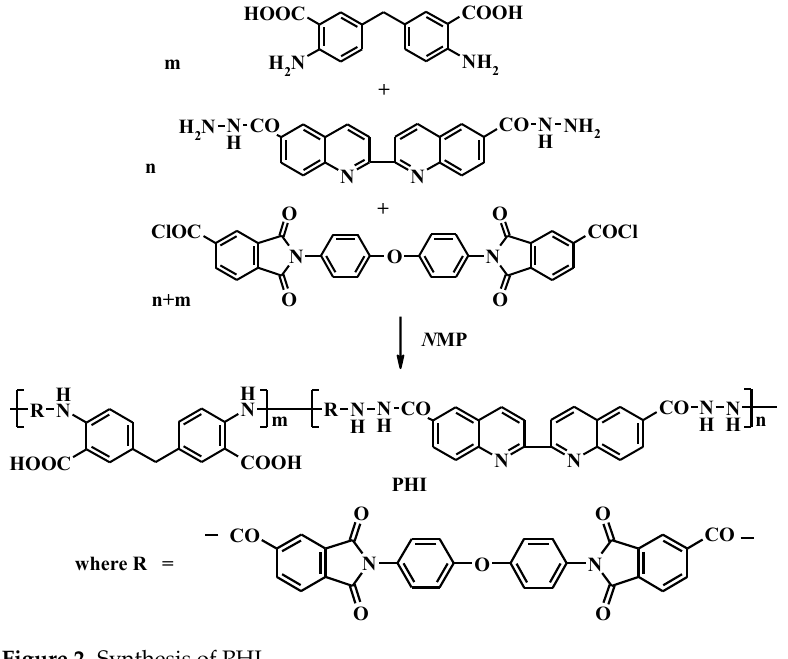
Figure 2. Synthesis of PHI.